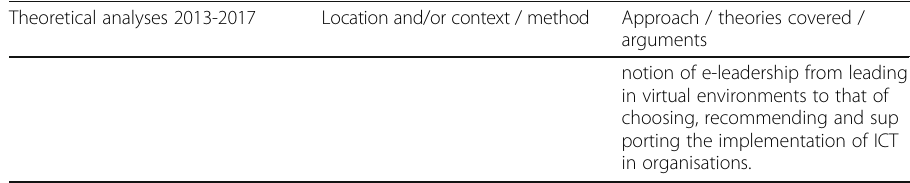
Table 3 Results: Theoretical analyses (Continued)